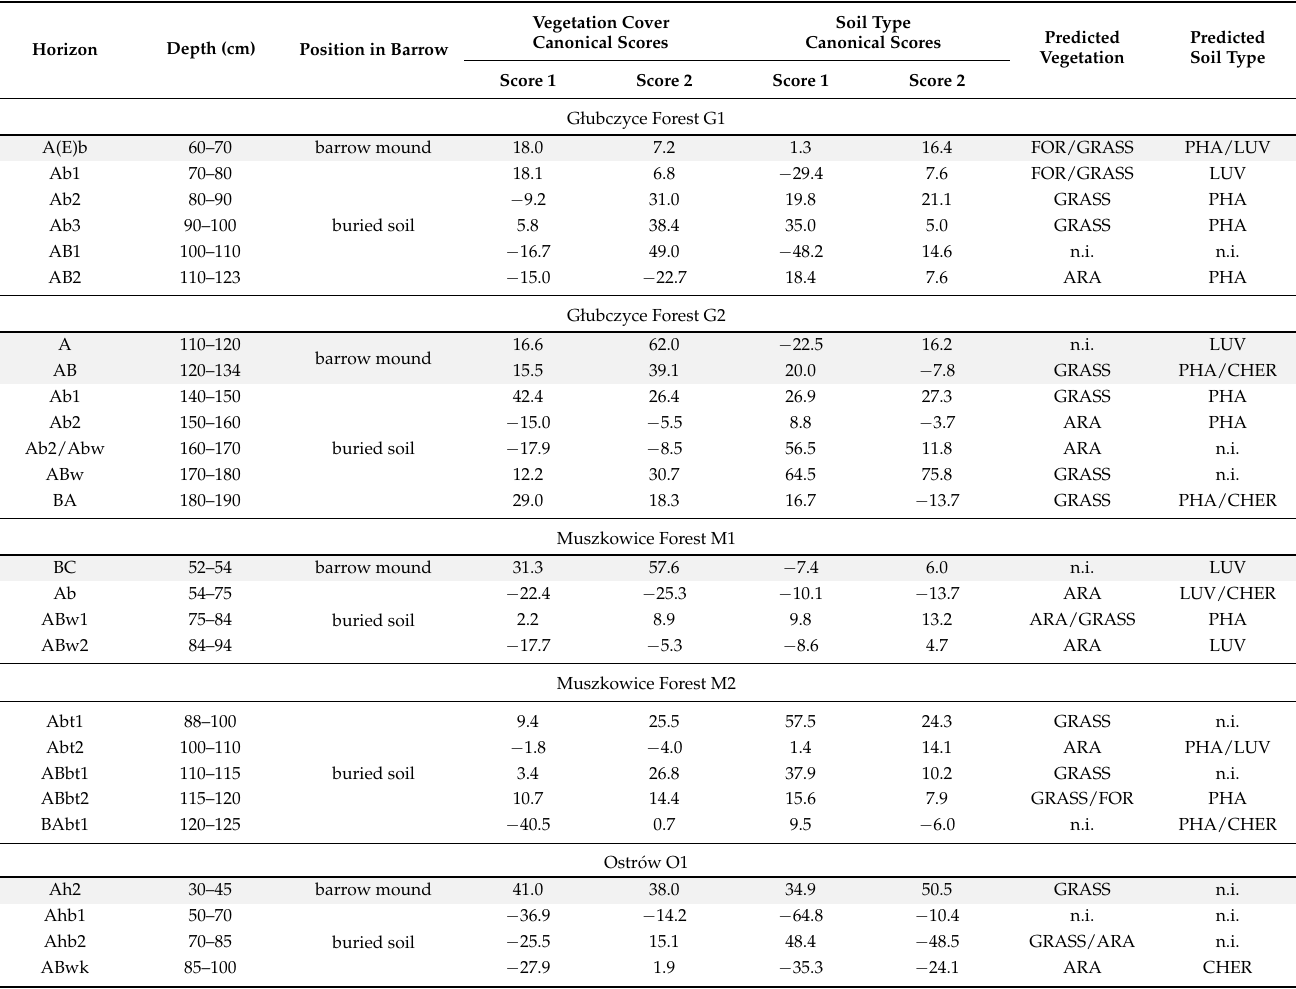
Table 3. Mid-infrared canonical scores for studied buried soils and barrow mound horizons, according to predicted past land use and soil